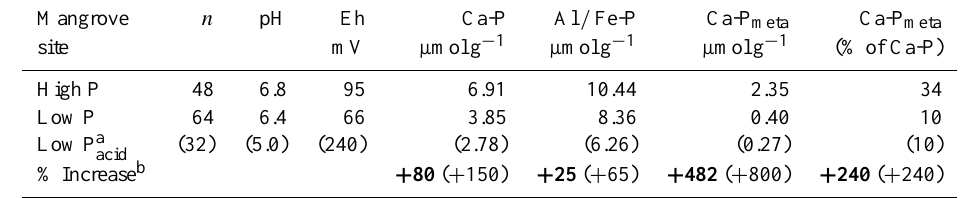
Table 3. Phosphorus fractions in mangrove sediments of the high P site (Firth of Thames) and low P site (Saigon River delta). Mangrove